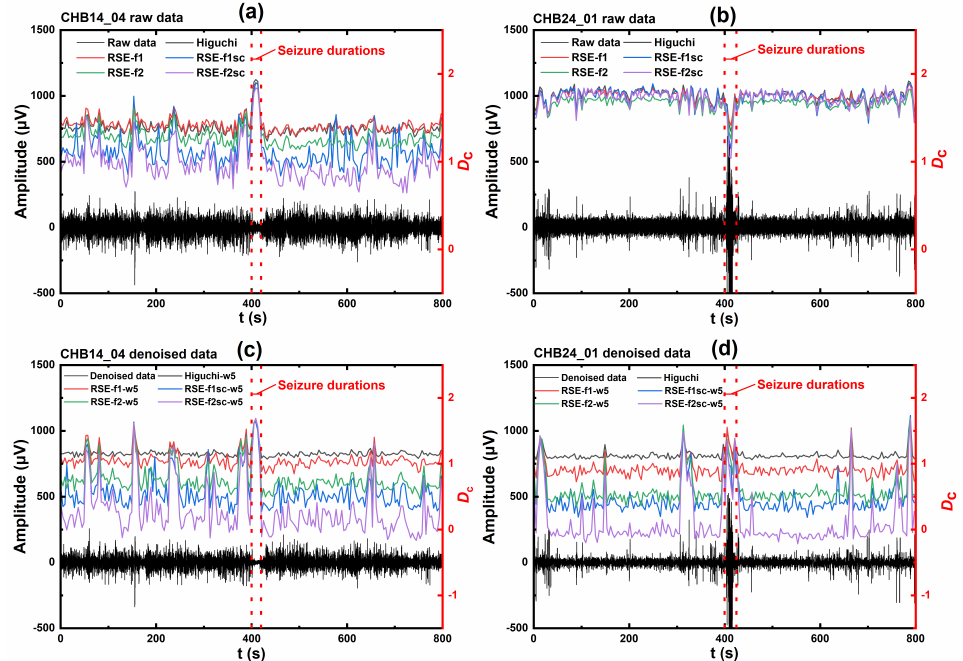
Figure 3. Typical EEG signals from ( a ) CHB14_04 raw data, ( b ) CHB24_01 raw data, ( c ) CHB14_04 denoised data and ( d ) CHB_01 denoised data with seizure durations (the range between red dotted vertical lines) and the corresponding variations of D c values, which were calculated by using Higuchi, RSE-f1, RSE-f1sc, RSE-f2 and RSE-f2sc algorithms,